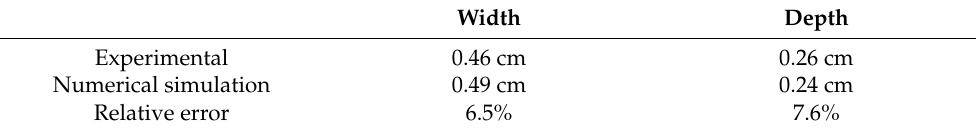
Figure A1. Transverse cross-sectional view of the molten track, where the left part is from the numerical results and the right part from the experiment [38]. Table A1. Comparison of melt pool width and depth between experiment data and simulation results.